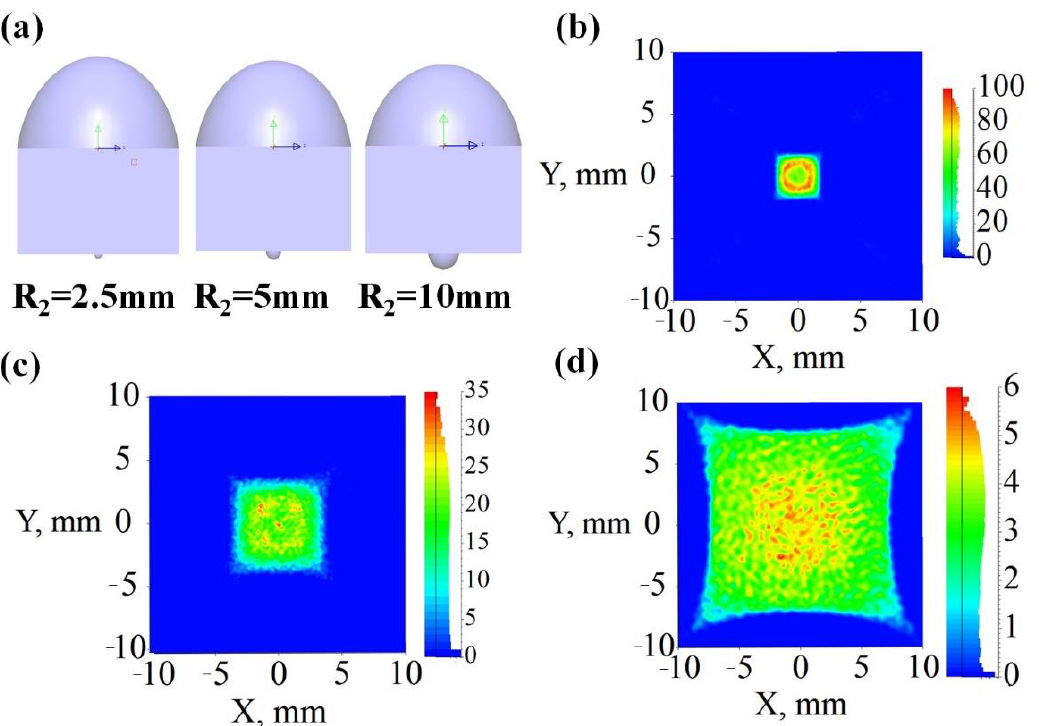
Figure 10. ( a ) Pictures of the proposed dual-lens concentrator unit with different radius of the image lens, R 2 = 2.5; 5; 10 mm, and a fixed radius of the objective lens R 1 = 50 mm. Light distribution on the receiver away from the image lens with a distance of 1 cm for the dual-lens concentrator unit having R 2 of ( b ) 2.5 mm, ( c ) 5 mm, and ( d ) 10 mm.